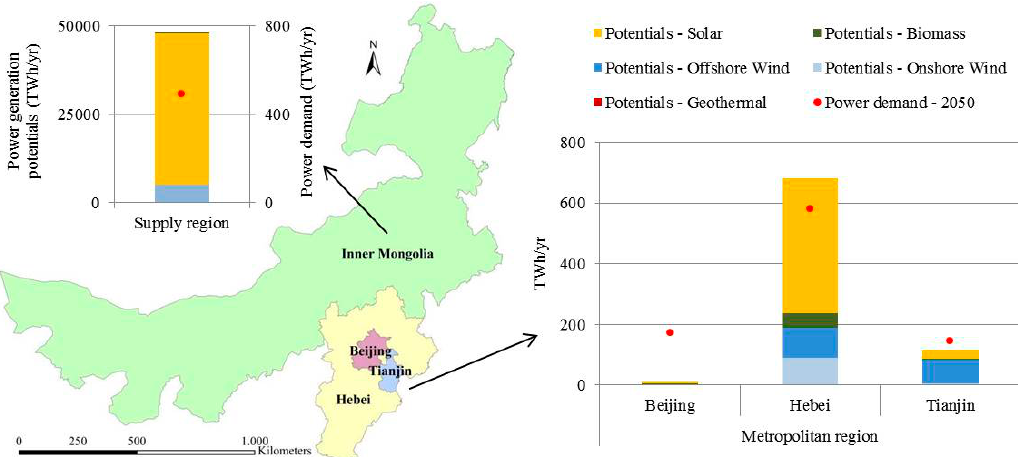
Figure 3. Renewable energy resources assessment compared to projected power demand in 2050 in supply region of Inner Mongolia and the metropolitan region of BTH (includes the demand from electric vehicles under RIS scenario).